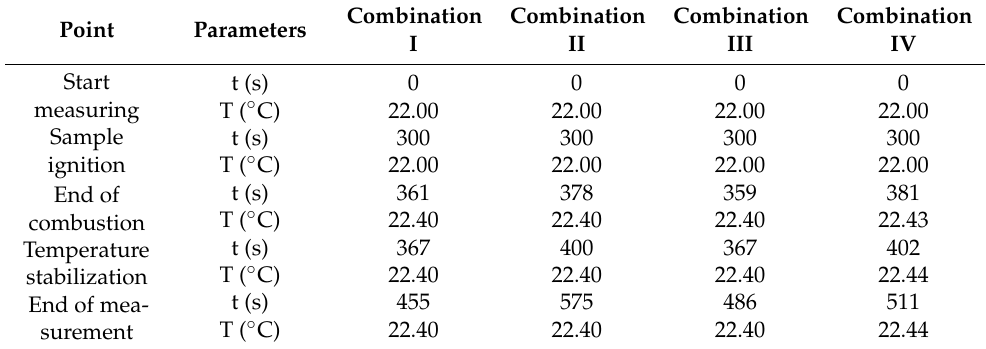
Table 3. Characteristic temperature points of larch sawdust